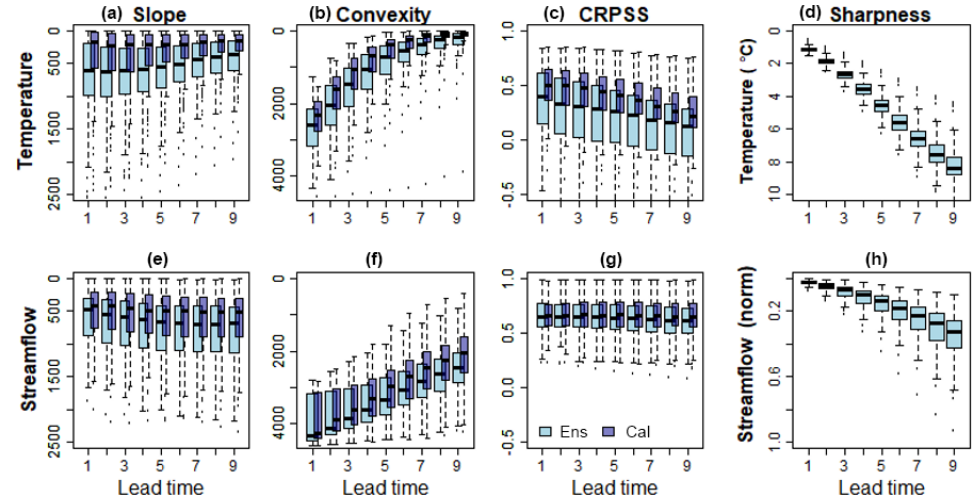
Figure 3. Summary of temperature and streamflow scores for all lead times. Each box represents the 139 catchments values averaged over all issue dates. Rank-histogram test decomposition for slope and convexity is shown in (a) , (e) , (b) , and (f) , respectively, and CRPSS in (c) and (g) . Panels (d) and (h) show sharpness for the uncalibrated forecasts. Temperature is shown in panels (a) – (d) and streamflow in (e) – (h) . Results are based on the full dataset and are shown for both uncalibrated (light blue) and calibrated (blue) ensembles at lead times of 1 to 9 days. For slope and convexity, 0 is the optimal value, and the scales are reversed so that the optimal value is on the top, corresponding to the CRPSS optimal value at